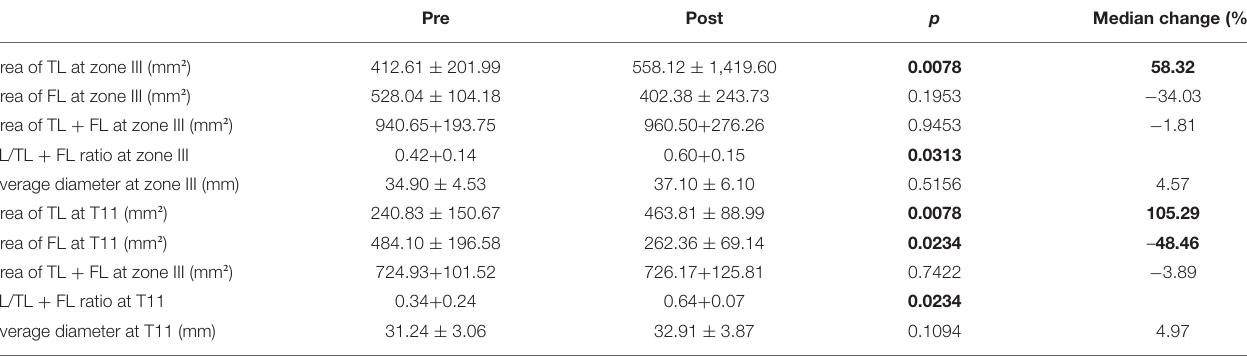
TABLE 5 | CT measurements.